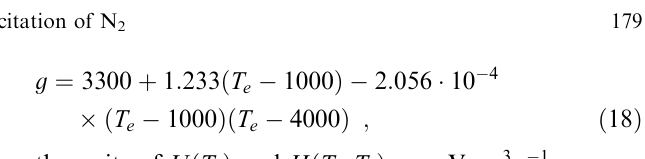
P 10 Q 0 v from the calculation v (cid:136) 1